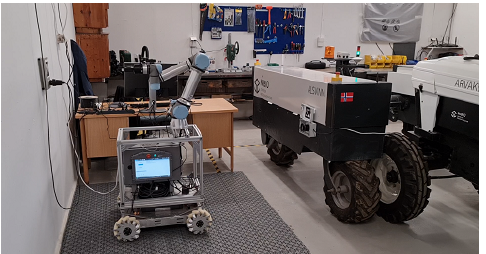
Figure 17. The ACS is back to an idle mode waiting to receive a new charging request through websocket from another